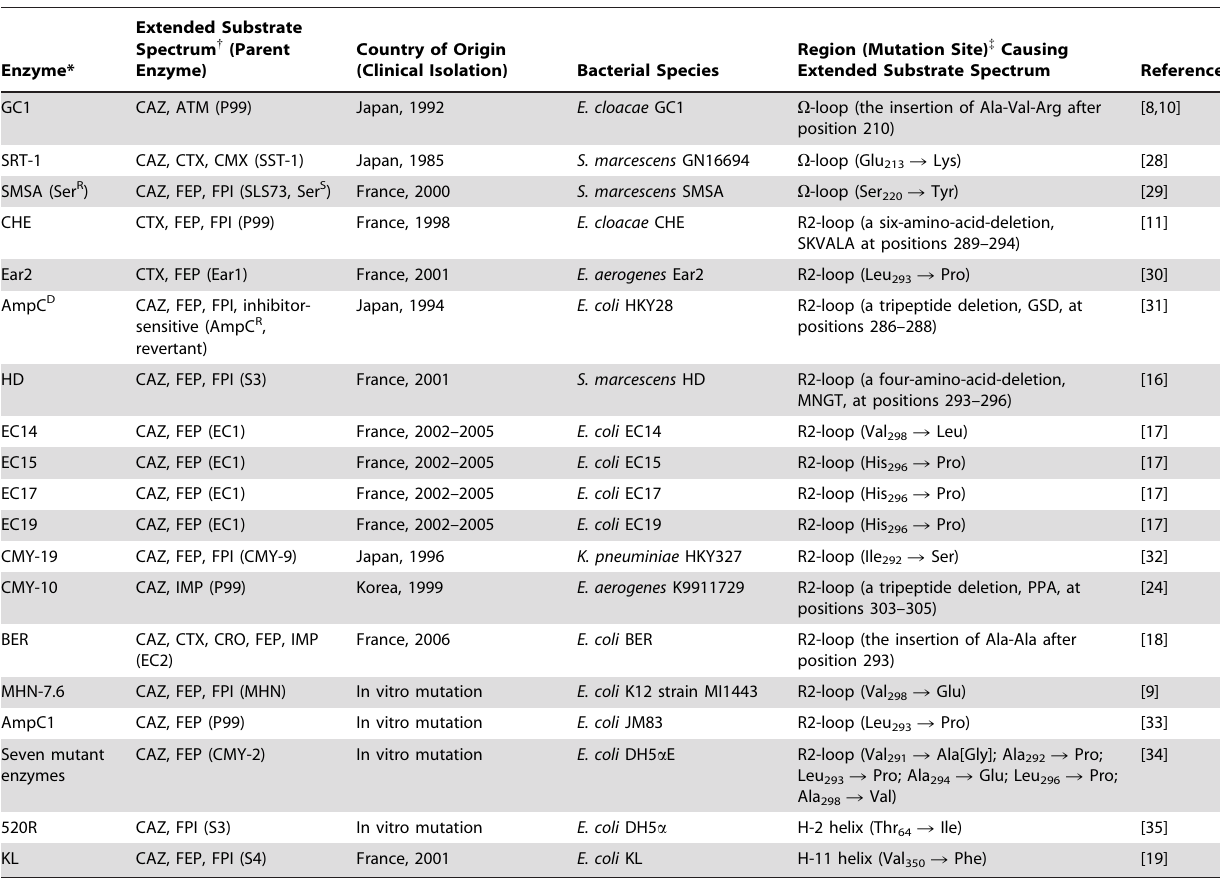
Table 1. Epidemiology and characteristics of class C extended-spectrum b -lactamases (cESBLs)